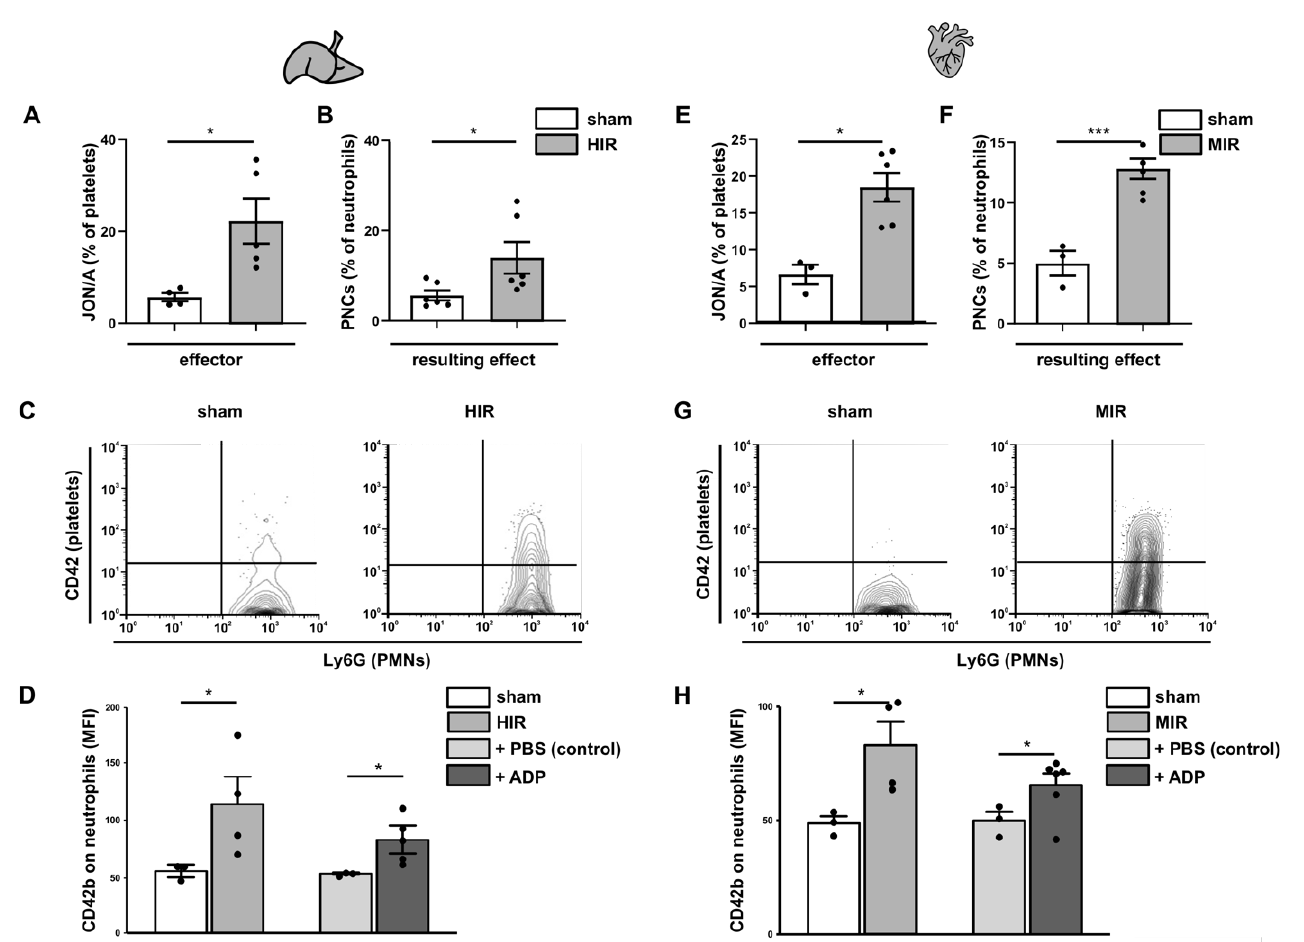
Figure 6. Ischemia and PNC formation. Hepatic (HIR; A – D ) and myocardial (MIR; E – H ) ischemia was induced followed by reperfusion in mice. ( A , E ) Platelet activation was assessed in whole blood by staining with JON/A antibodies and is depicted as percentage of platelets. ( B , F ) PNC formation was depicted as percentage of CD42b positive neutrophils. ( C , G ) Representative contour plots of ( B ) and ( F ), respectively. ( D , H ) Additionally, mean fluorescence (MFI) of CD42b positive platelets measured on the surface of neutrophils from sham (white bars) and IR mice (black bars) is depicted. Blood from sham mice was incubated ex vivo with PBS (grey) or ADP (dark grey). n = 3–5 mice; unpaired Student’s t -test with * for p < 0.05; *** for p < 0.001.